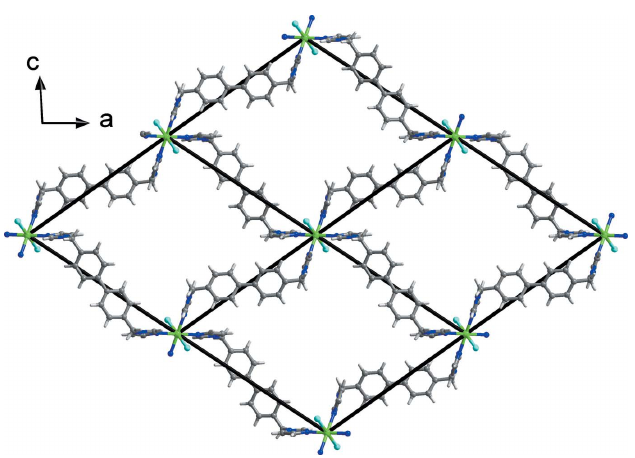
Figure 2 The two-dimensional structure of the title compound with sql network viewed along the b axis.